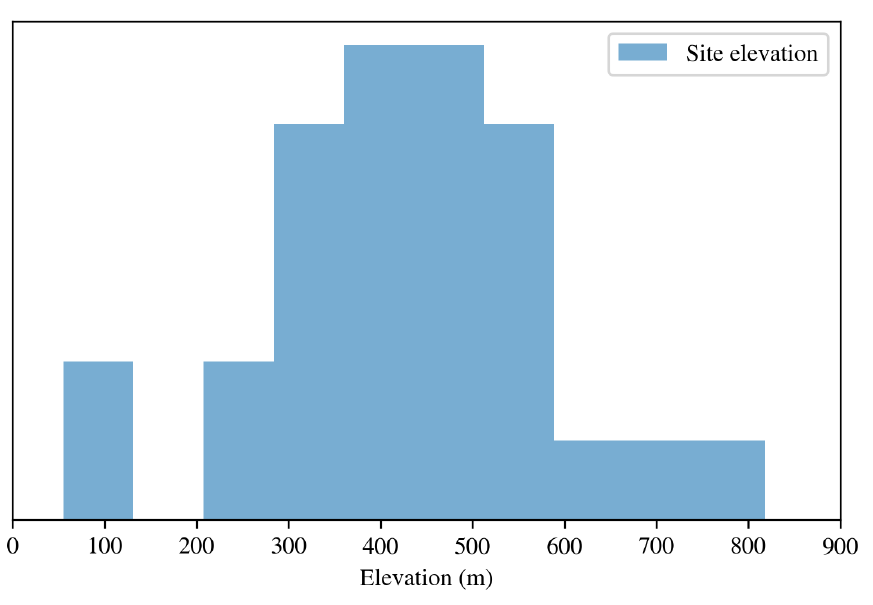
Figure 3. Histogram of the elevation of all